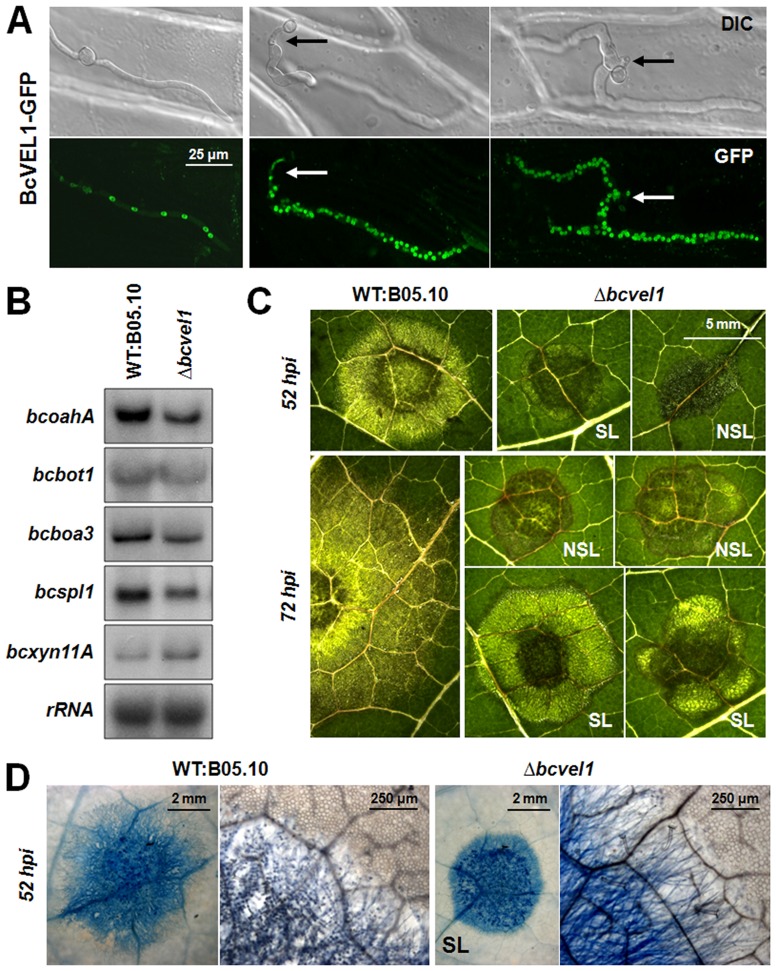
Impact of BcVEL1 on invasive growth.(A) Subcellular localization of BcVEL1-GFP (in the B05.10 genomic background) during infection of onion epidermal layers (24 hpi). The localization is shown in hyphae that are growing on the top of the cells (left panel) or growing invasively (middle and right panel); arrows indicate sites of penetration. (B) Expression of known virulence factors in B05.10 and Δbcvel1 in planta. Primary leaves of P. vulgaris were inoculated with conidial suspensions and harvested 48 hpi (primary lesions, prior to lesion spreading). Northern blots were hybridized with probes of bcoahA (oxalic acid biosynthesis), bcbot1 (botrydial biosynthesis), bcboa3 (botcinic acid biosynthesis), bcspl1 (cerato-platanin family protein) and bcxyn11A (endo-beta-1,4-xylanase) coding sequences. rRNA is shown as loading control. (C) Close-up views of lesions caused by B05.10 and Δbcvel1 on P. vulgaris. Outcome of the Δbcvel1-plant interaction is variable: infection stops in primary stage (NSL, non-spreading lesion) or proceeds slowly (SL, spreading lesion). (D) Trypan blue staining of spreading lesions (52 hpi). Fungal hyphae and dead plants cells are stained blue. The right panels show higher magnification of the edges of the lesions. Only few dead plant cells were observed around Δbcvel1 lesions, while massive staining of plant cells in the range of the wild-type lesions indicates the complete maceration of the tissue.